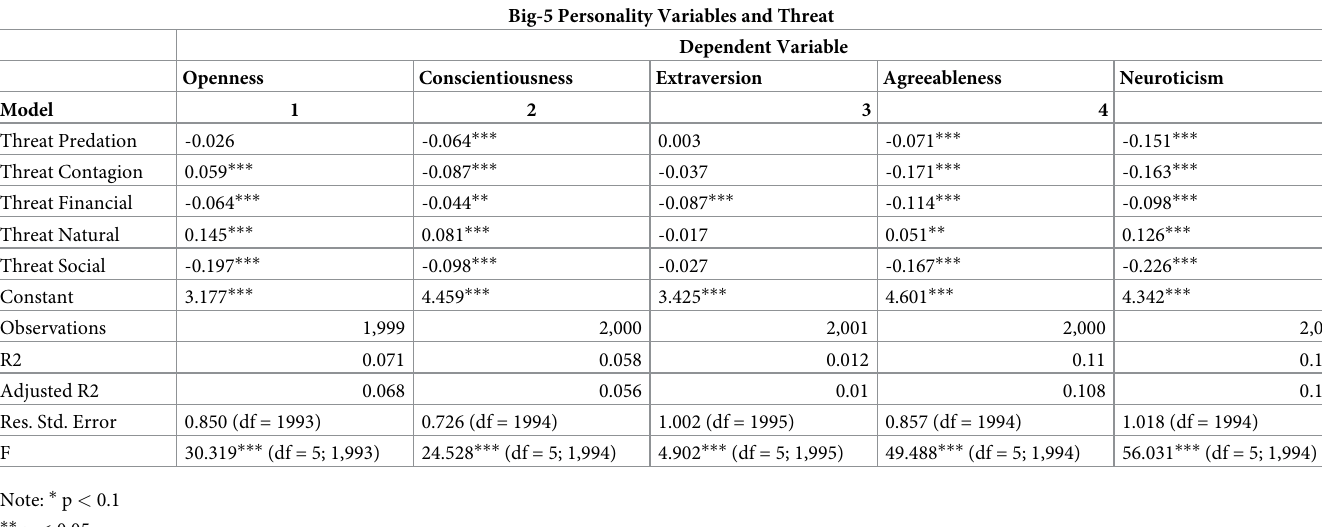
Table 6. Regressions showing the effects of threats on different personality traits from the Big-5 personality measures.